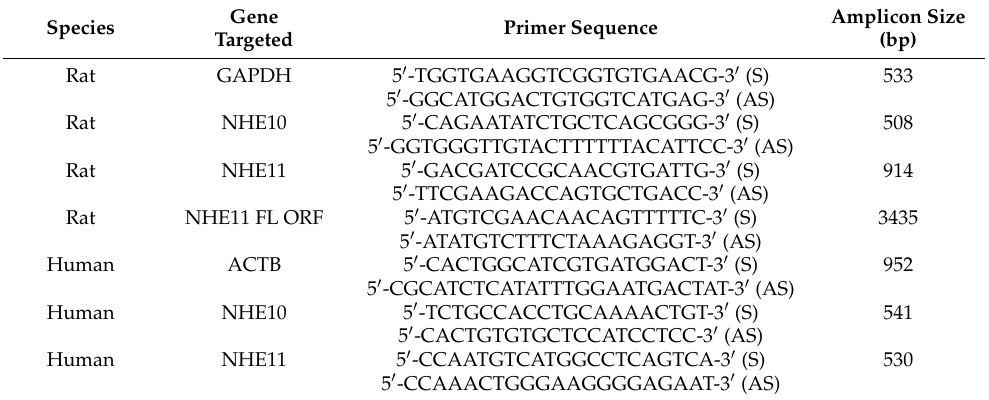
Table 1. Primers used in this study for RT-PCR analysis. (S) is a sense primer and (AS) is an antisense